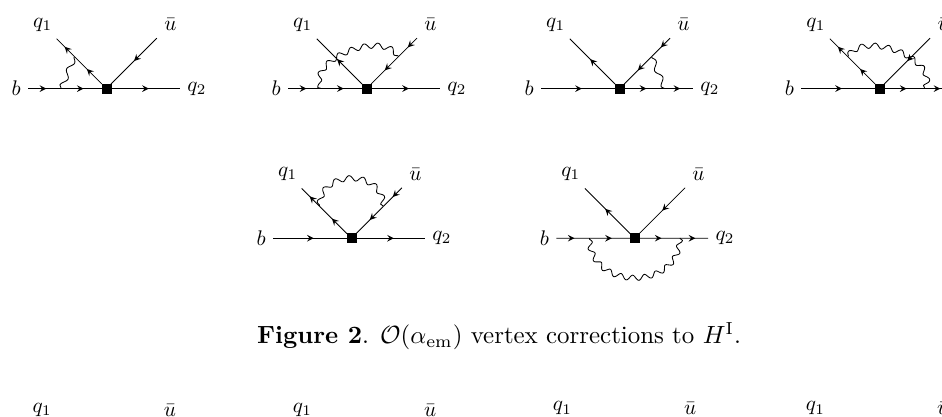
Figure 2 . O ( α em ) vertex corrections to H I .